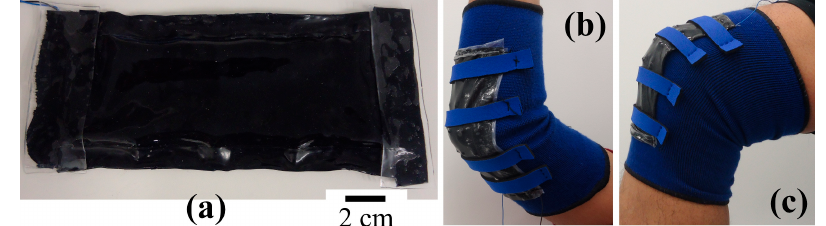
Figure 2. Photoghraph of ( a ) top view of device; ( b ) TrEG mounted on elbow; and ( c ) on